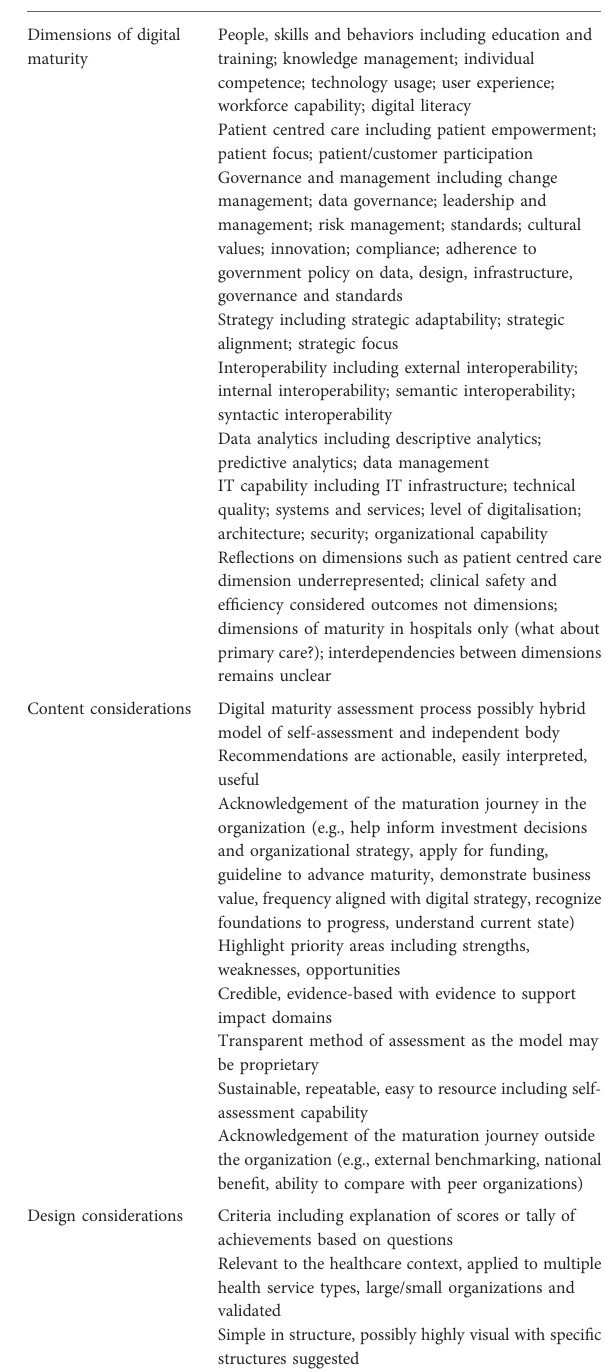
TABLE 2 Content and design considerations which informed the